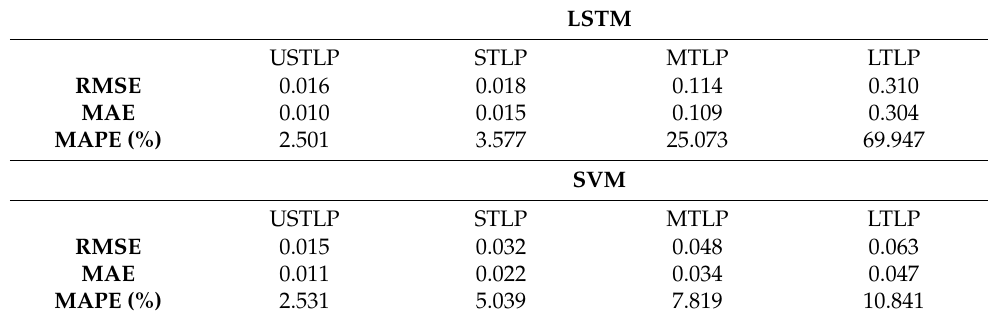
Table 3. Model metric for algorithms in the test dataset.